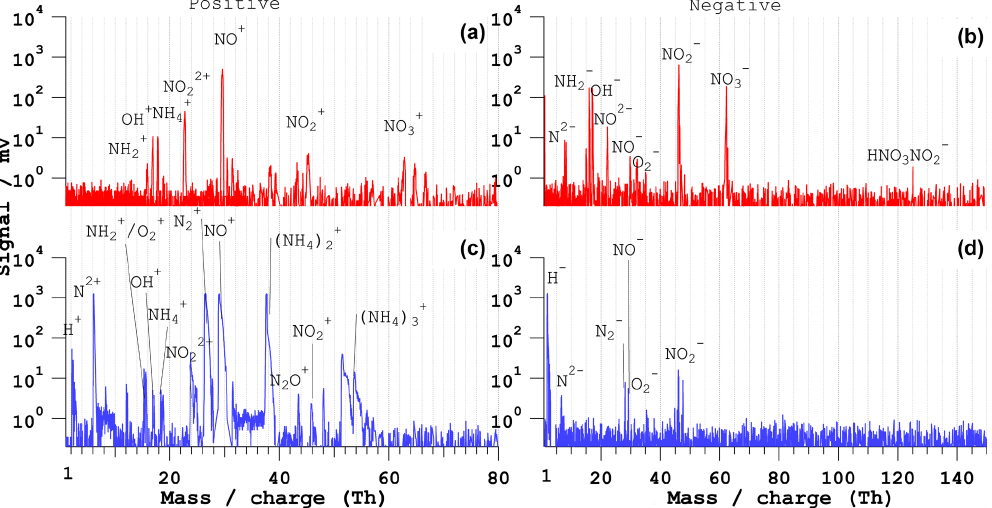
Figure 5. Bipolar mass spectra of NH 4 NO 3 particles of d p = 400nm. (a, b) Typical ns-LAAPTOF spectra and (c, d) fs-LAAPTOF ( λ = 800nm) spectra. The pulse energy is 4mJ for the ns laser and 3.2mJ for the fs